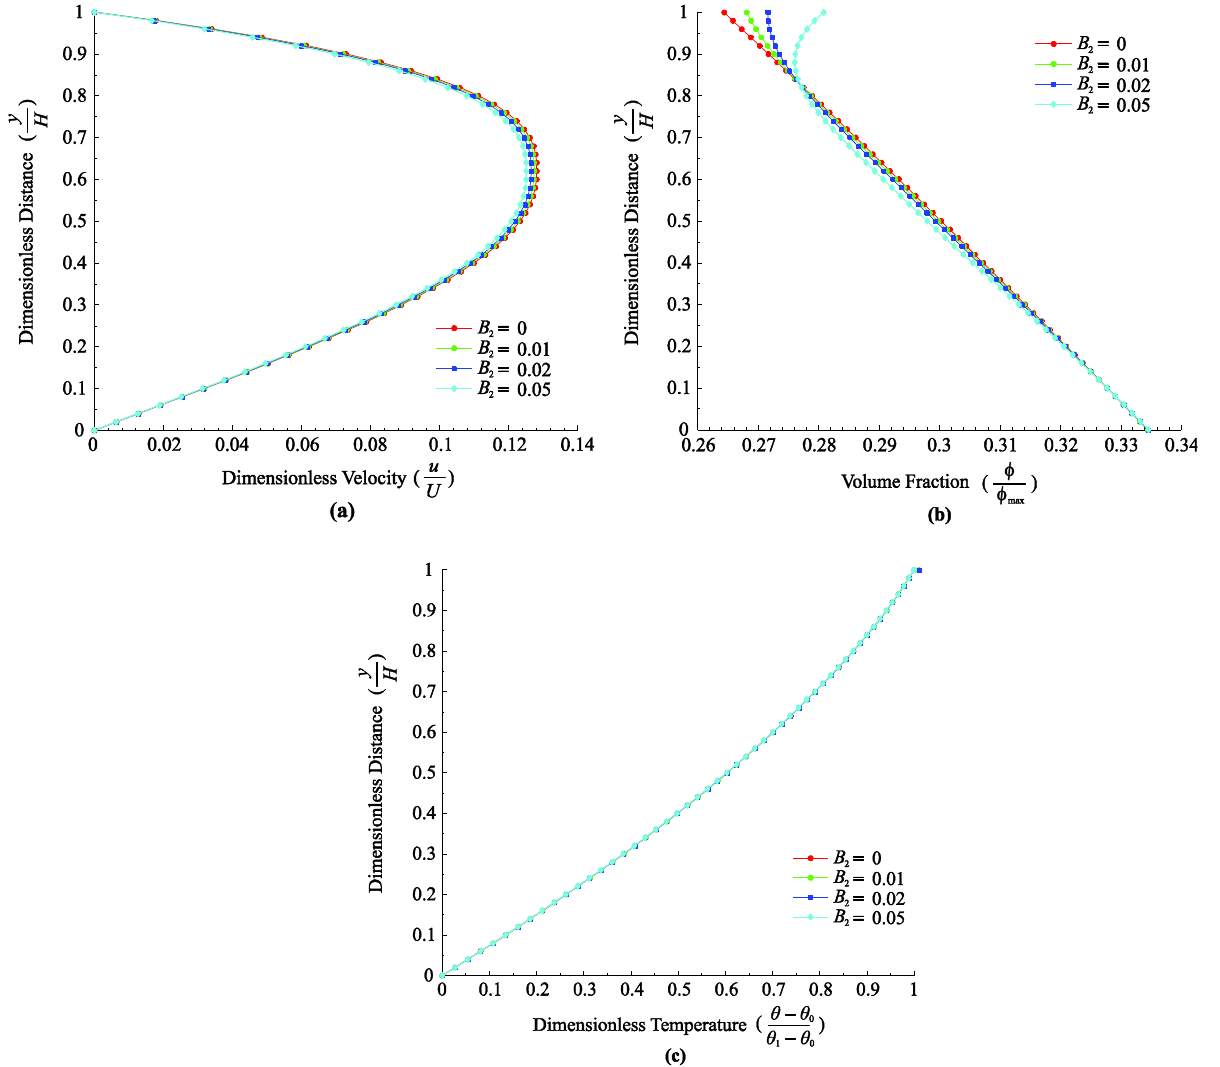
Figure 7. ( a ) Effect of 𝐵 volume fraction distribution. ( c ) Effect of 𝐵 𝑚 = −0.3, 𝑀 = 1, 𝐵 −0.02, 0.01, 2.3, −9, 11